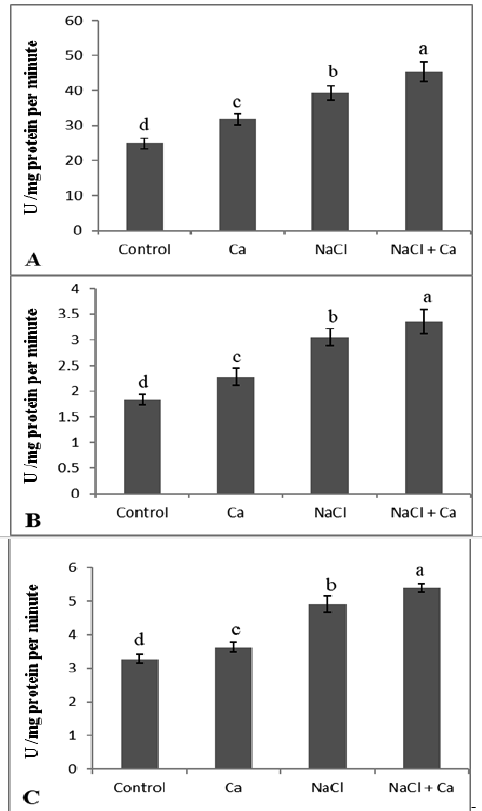
Fig. 5: Effect of salinity stress (100 mM NaCl) on activity of (A) superoxide dismutase (B) ascorbate peroxidase and (C) glutathione reductase in soybean ( Glycine max L.) with and without calcium supplementa‑ tion. Data is mean (±SE) of three replicates and bars with different letters denote significant difference at P ≤ 0.05